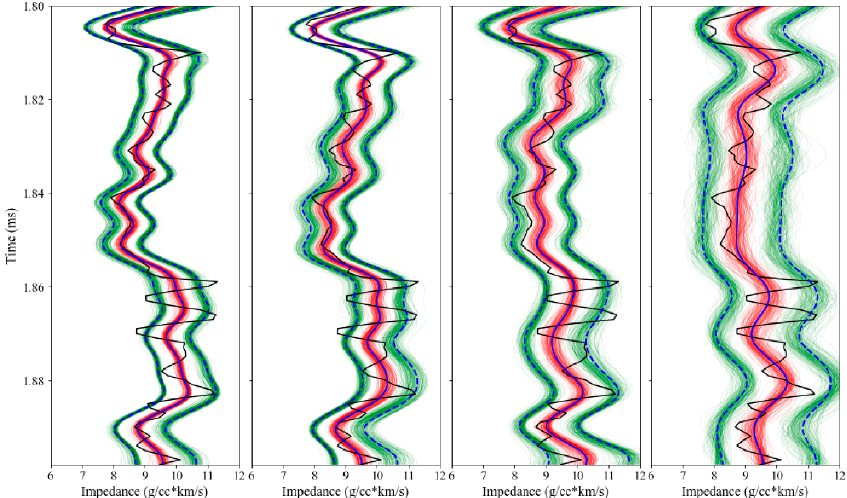
Figure 5. Inversion results obtained from seismic data with different noises level (the variances are 10 − 5 , 10 − 4 , 10 − 3 , and 10 − 2, respectively, from left to right). Black solid lines represent the true model, blue solid lines represent the final MAP solution of the inversion. Blue dotted lines represent the 0.95 confidence interval of the final result. Red lines represent MAP solutions corresponding to 200 of 4900 wavelet and noise variance samples.